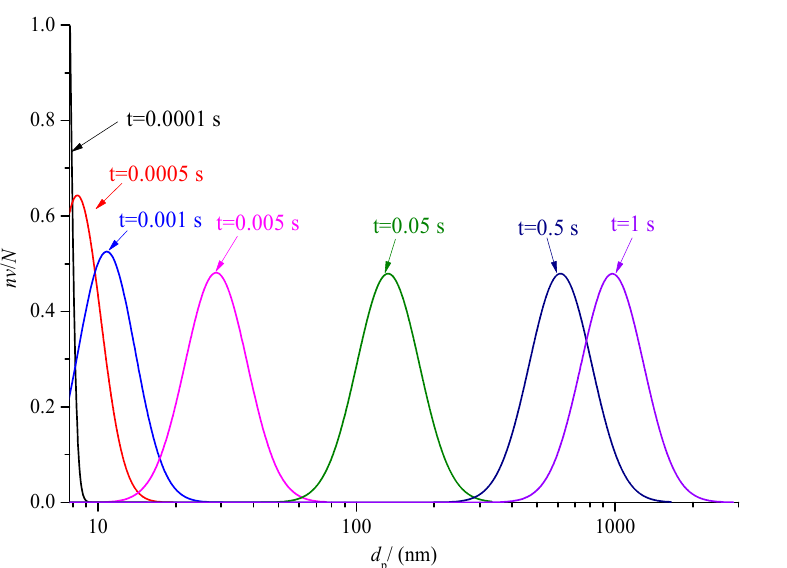
Figure 20. Comparison of sulfur particle size distribution at different time logarithmic coordinates ( nv / N ).